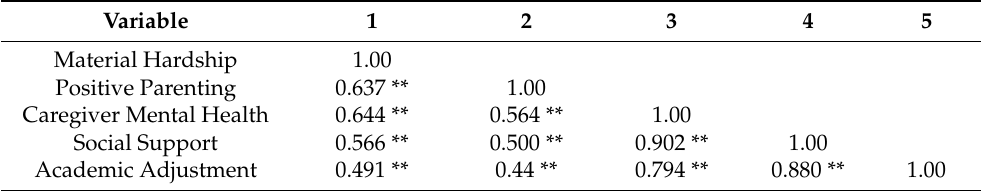
Table 2. Variable Correlation